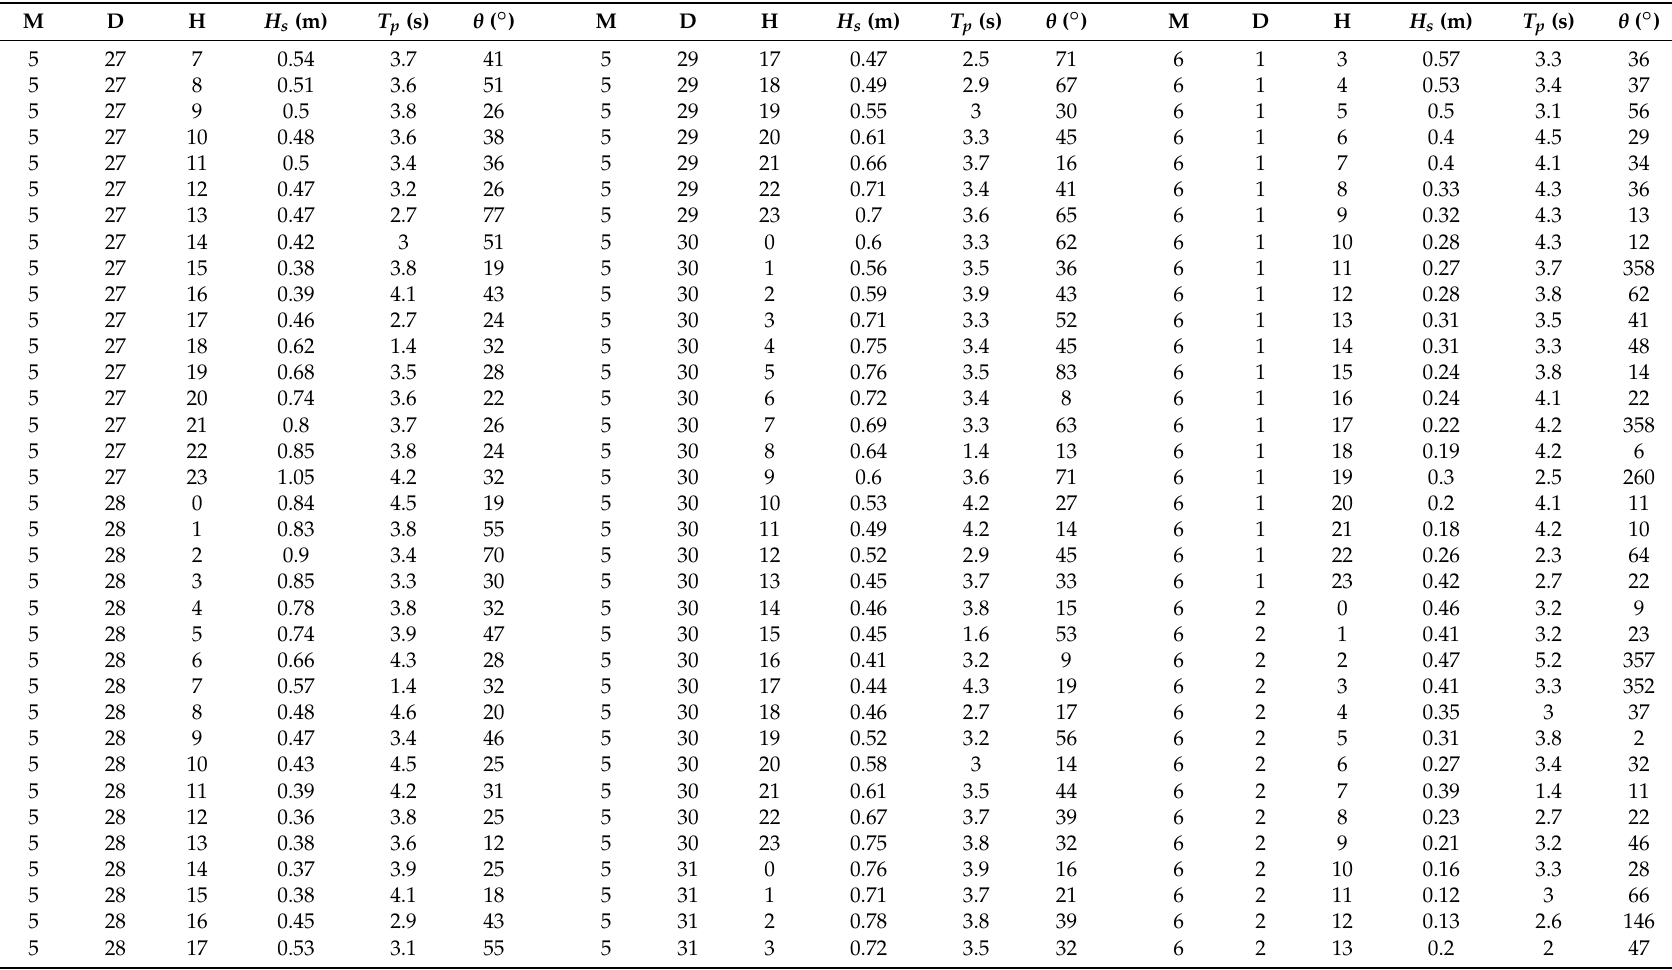
Table 2. Observed wave conditions from 27 May 2015 to 3 June 2015; M = month, D = day, H = hour, H s = significant wave height, T p = peak wave period, θ = wave